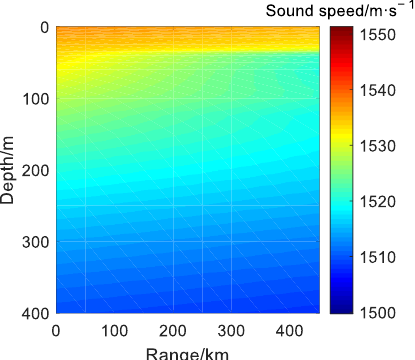
Figure 1. Sound speed profile with linear variation.